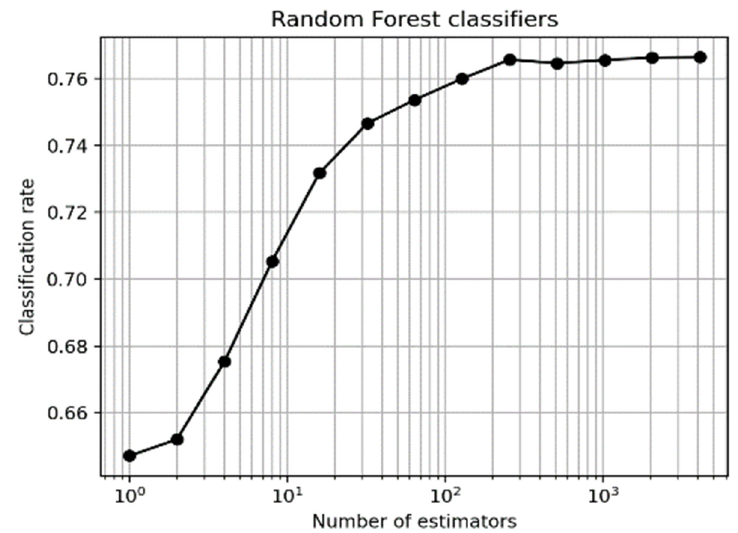
Figure 4. Tuning the number of trees (estimators) in the random forest ensemble for the health change predictor utilizing previous health.